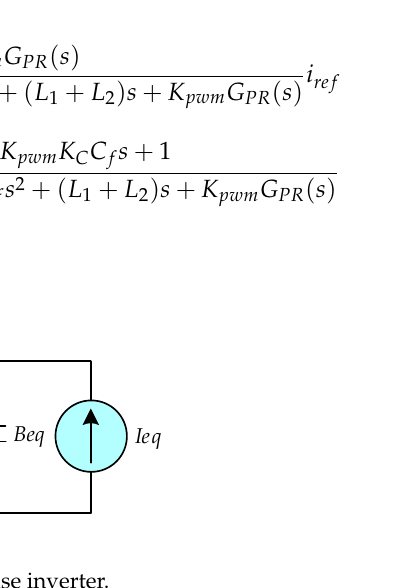
Table 1. Control and electrical parameters of the inverter. Symbol Instruction Values proportionality coefficient 0.4 resonance coefficient